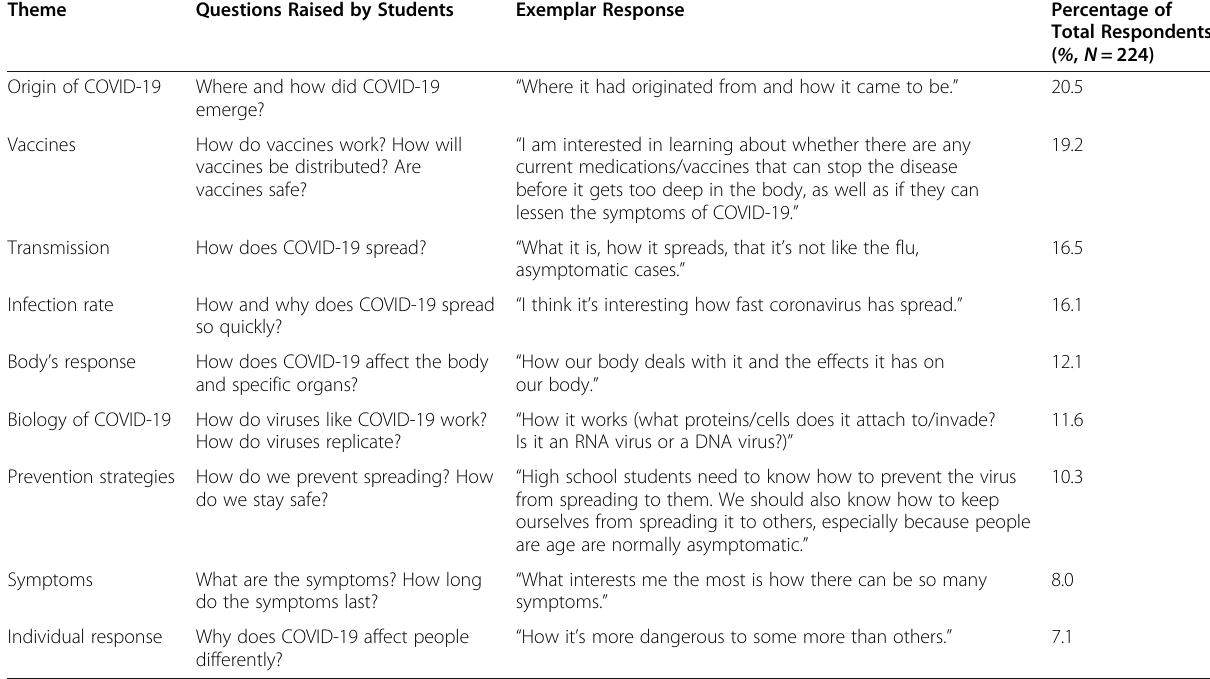
Table 1 Thematic Analysis of Student Interest Related to